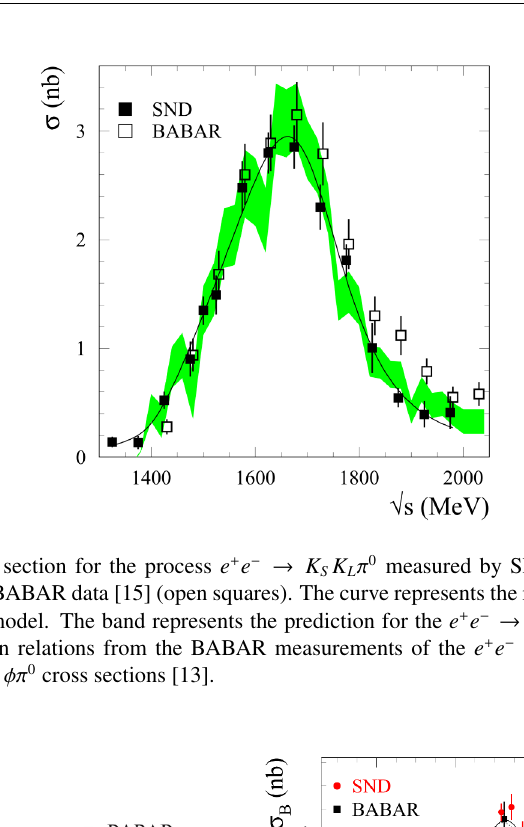
Figure 5. The e + e − → η K + K − cross section mea- sured by SND in comparison with the BABAR measurement [13]. The curve represents the re- sults of the VMD fit to the SND data.